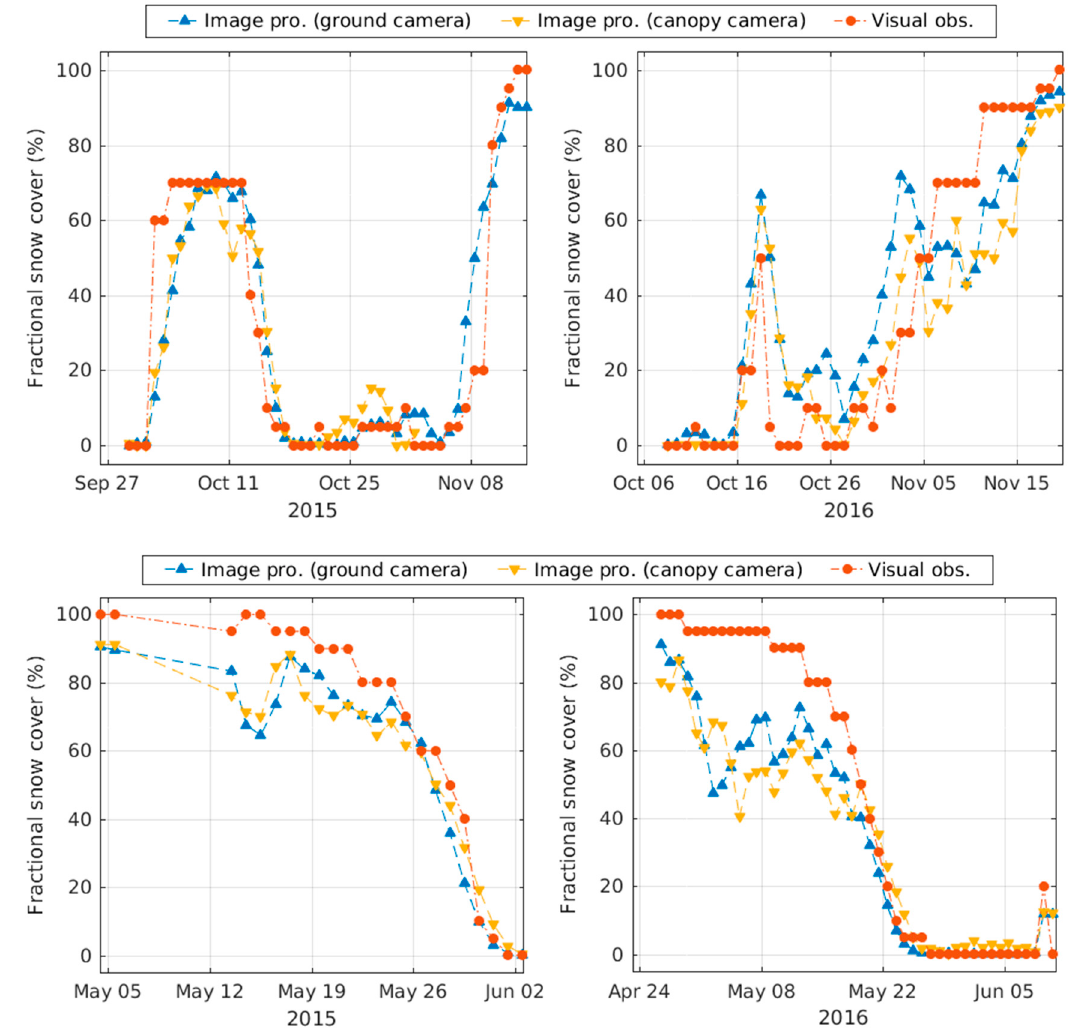
Figure 8. Kenttärova ground and canopy cameras early season ( top ) and melting season ( bottom ); comparisons of image processing results and visual observations.